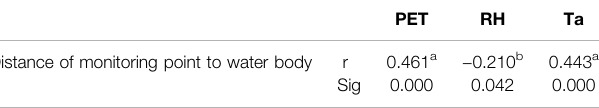
TABLE 4 | Correlation coef fi cients between distance to the water body and simulated data. Distance of monitoring point to water body r